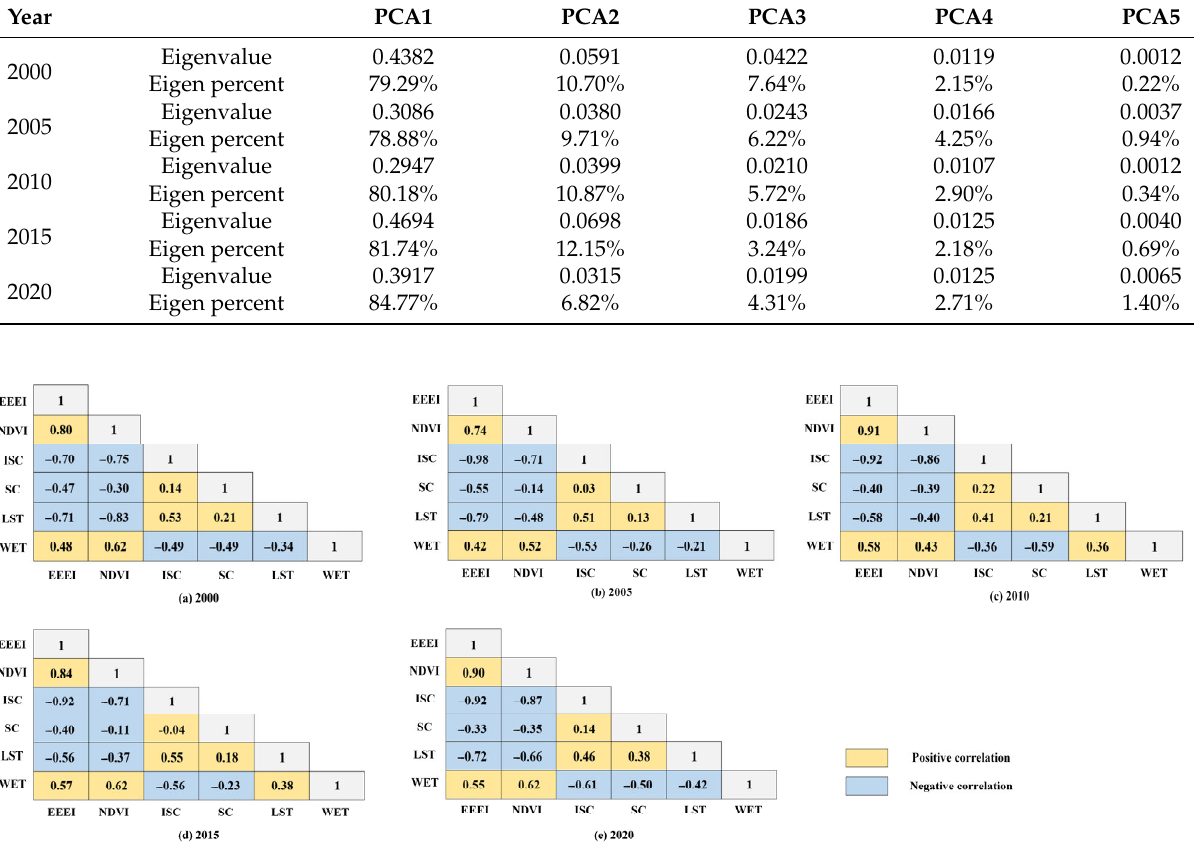
Table 5. Classification criteria of ecological quality of the GBA from 2000 to 2020.